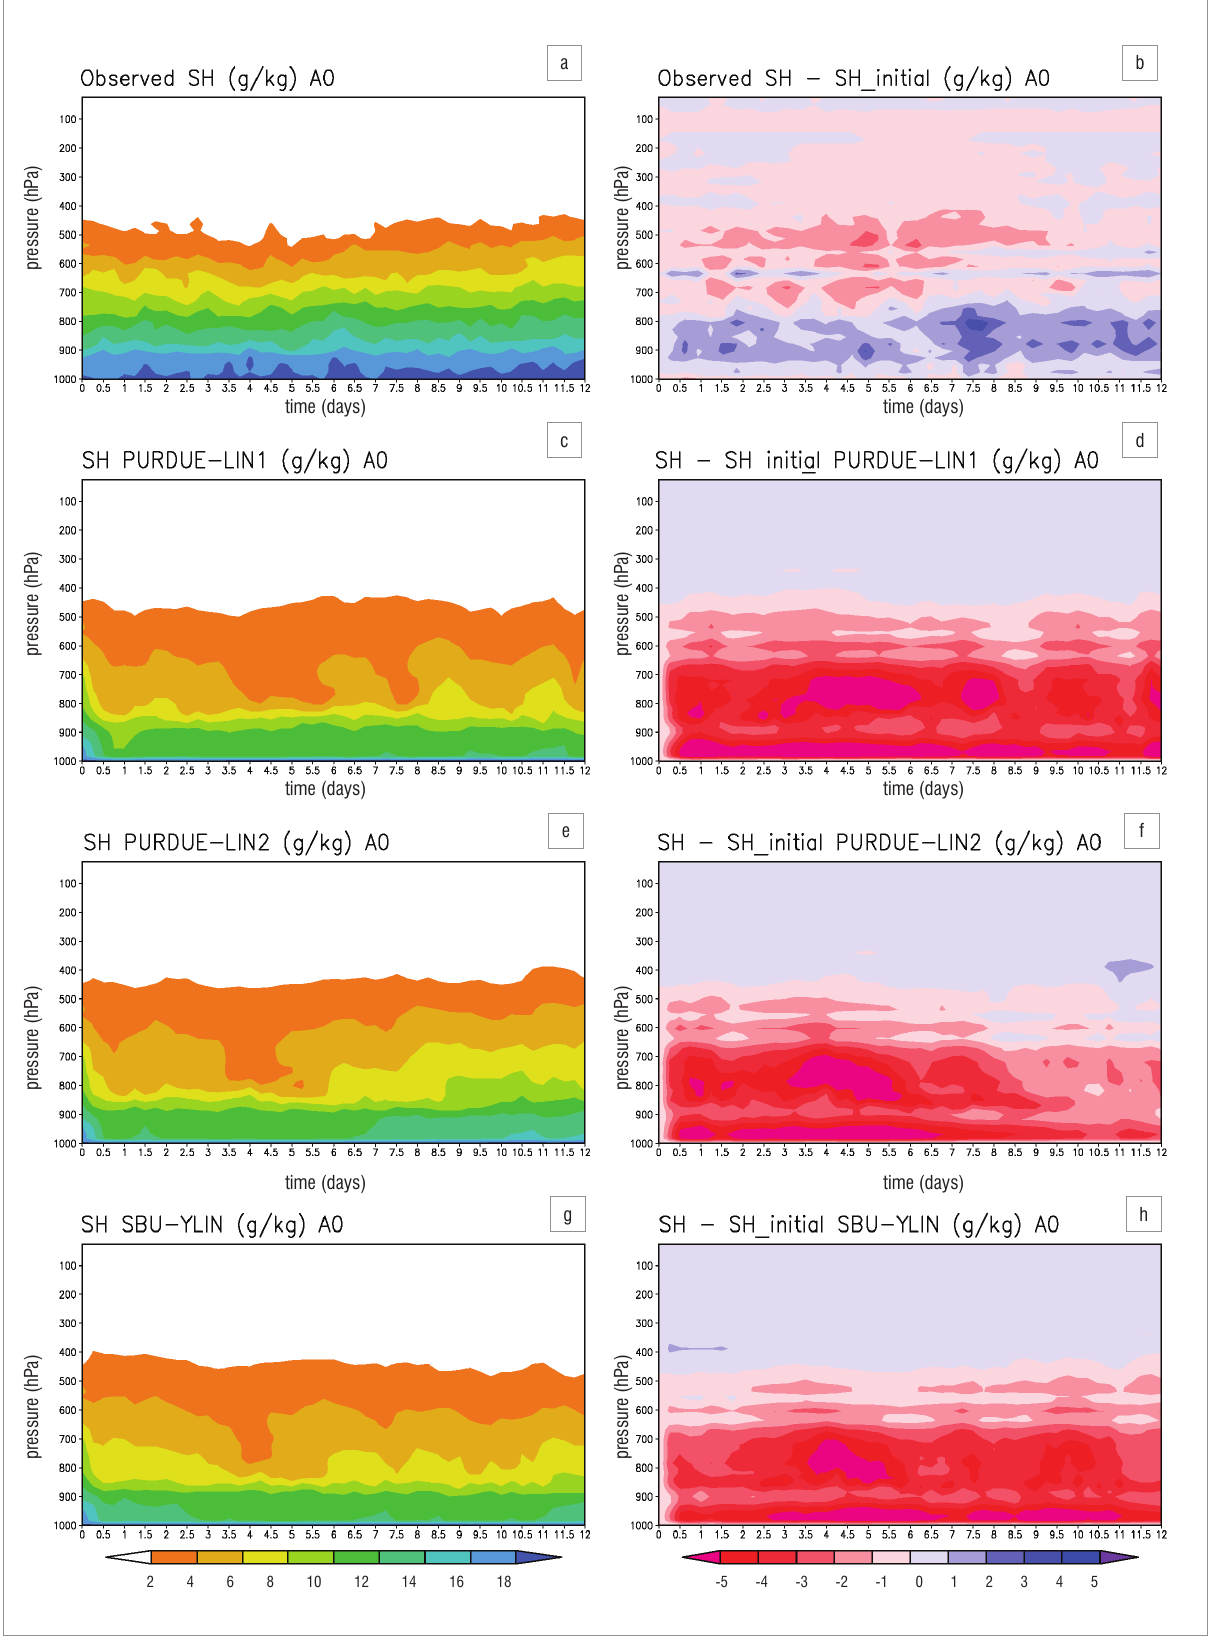
Figure 3: The temporal evolution of the (a) observed specific humidity and (b) observed specific humidity relative to the initial conditions. (c,e,g) The temporal evolution of the simulated specific humidity by the different microphysics schemes and (d,f,h) specific humidity relative to the initial conditions for the A0